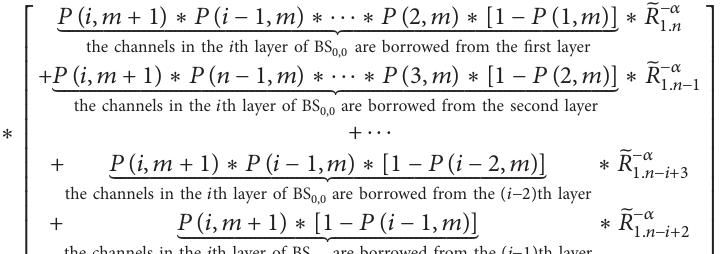
Figure 5: Cochannel frequency interference analysis model.